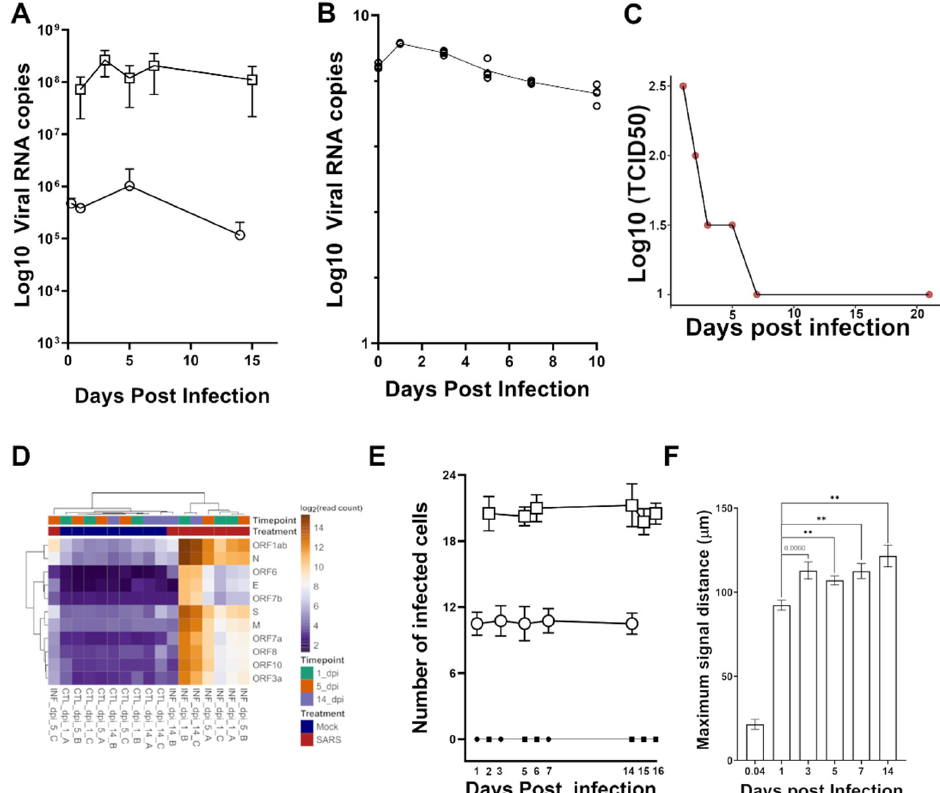
Figure 2. SARS-CoV-2 shows negligible infectivity in hamster brain cerebellar slice culture. Viral RNA in ( A ) lysate or ( B ) culture medium from cerebellar slice cultures infected with SARS-CoV-2 was quantified using qRT-PCR targeting the nucleocapsid sequence. Either 450 ( A ; open circles) or 6850 ( A ; open squares) PFU of SARS-CoV-2 inoculum was used to challenge the cerebellar slice cultures. DPI is indicated on the x- axes and the viral RNA (log 10 ) quantified by qRT-PCR is indicated on the y -axes. Live virus in hamster brain cerebellar slice cultures was quantified ( C ) following inoculation with SARS-CoV-2 using TCID 50 assay. DPI are indicated on the x- axis and the viral titer is indicated on the y -axis. ( D ) Hierarchical clustering of RNAseq raw read counts mapping to SARS-CoV-2 transcripts were normalized and abundance was calculated as log2 transformed read counts using DESeq2. Bar diagrams depicting ( E ) the number of cells infected with SARS-CoV-2; circles and squares indicate slices infected (white) with 450 PFU and 6850 PFU respectively as compared to relevant controls (black) and ( F ) maximum signal distance (in µ m) of viral nucleocapsid protein from the centre of the infected cells as visualized by indirect immune fluorescence imaging. The time points are indicated on the x -axis; 0.04 is 1 h post infection. Values are depicted as mean ± SEM; N = 4 ** indicates a statistical significance with a p -value < 0.005; actual p -value (0.006) is indicated otherwise.